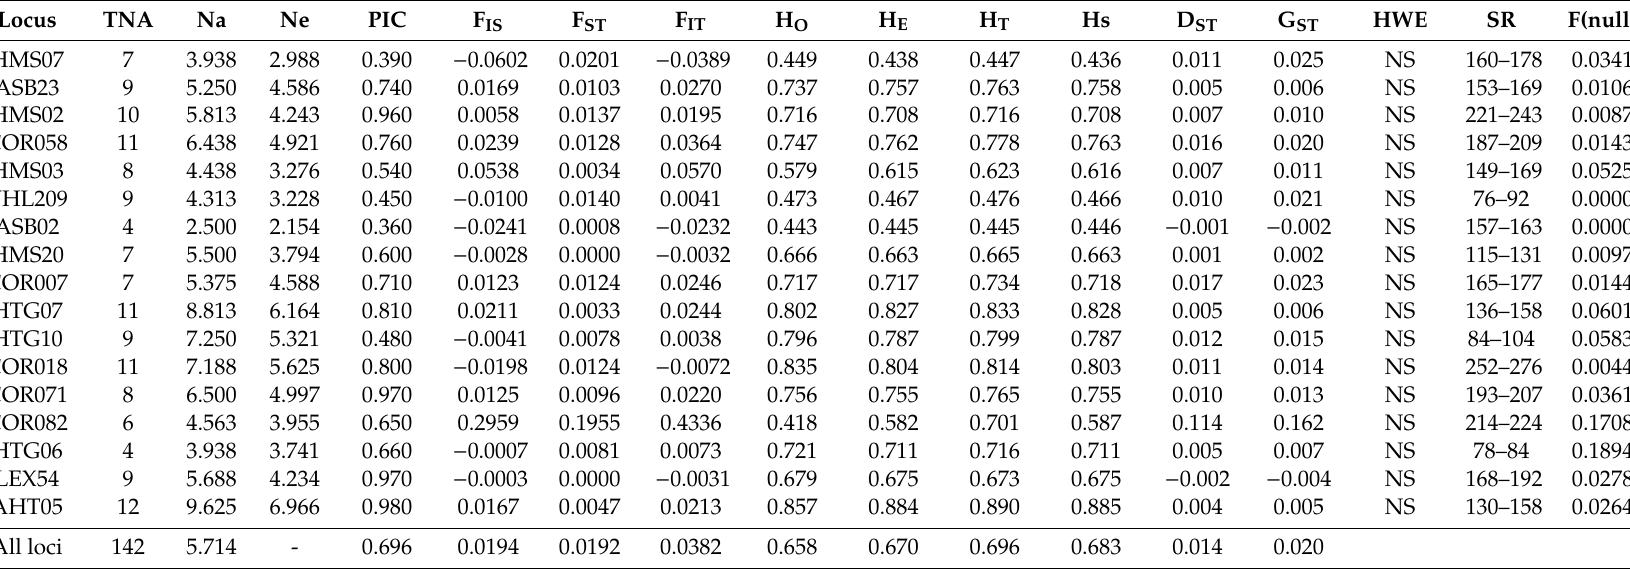
Table 4. Genetic diversity parameters estimated for 17 microsatellite markers over all populations. TNA—total number of alleles; Na—mean number of alleles; Ne—e ff ective number of alleles; PIC—polymorphic information content for each locus; F statistics (Fis, Fst, Fit); H O —observed heterozygosity; H E —expected heterozygosity; H T —Nei’s gene diversity; Hs—diversity within breeds; D ST —diversity between breeds; G ST —coe ffi cient of gene di ff erentiation; HWE—test for significant deviation from Hardy-Weinberg equilibrium with the hypothesis of the heterozygote excess; SR—Size range of the observed allele in